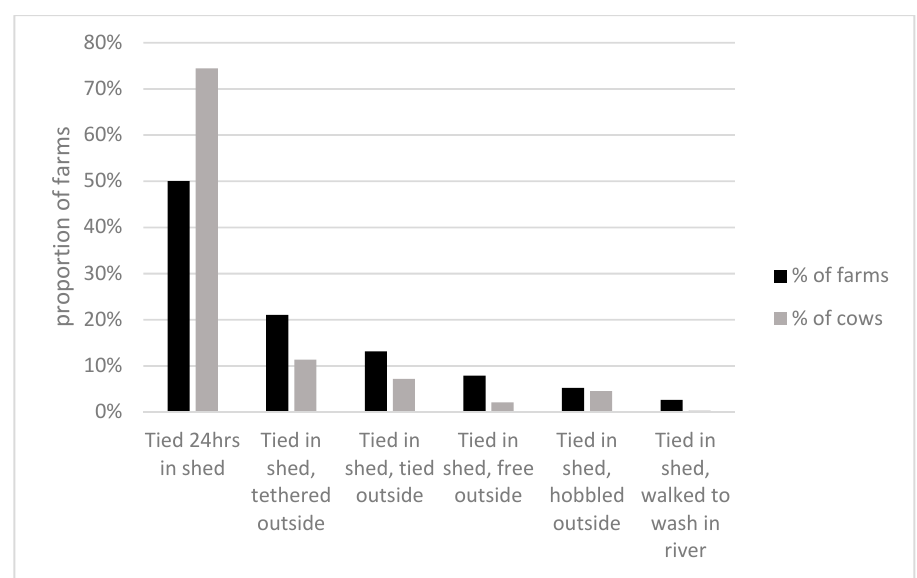
Figure 2. The different farm systems in use in the study. Figure 2. The di ff erent farm systems in use in the